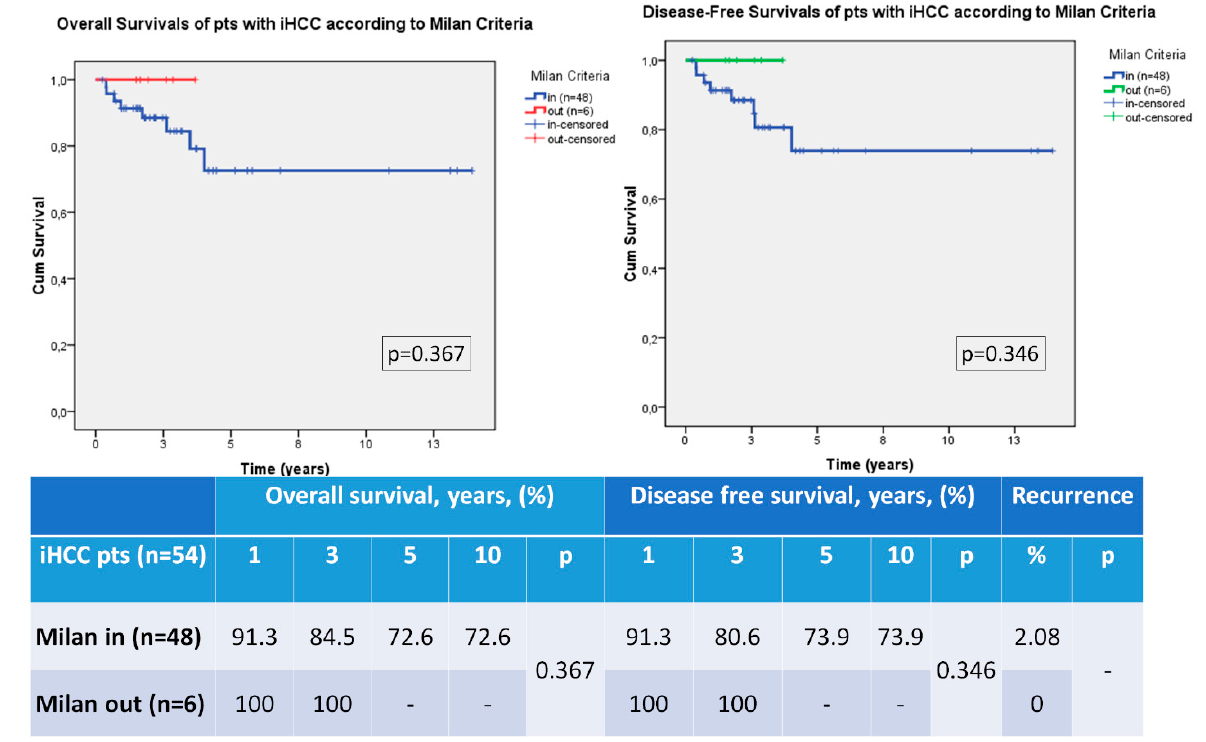
Figure 3. Survival comparison of iHCC patients (iHCC in Milan vs. iHCC out of Milan).